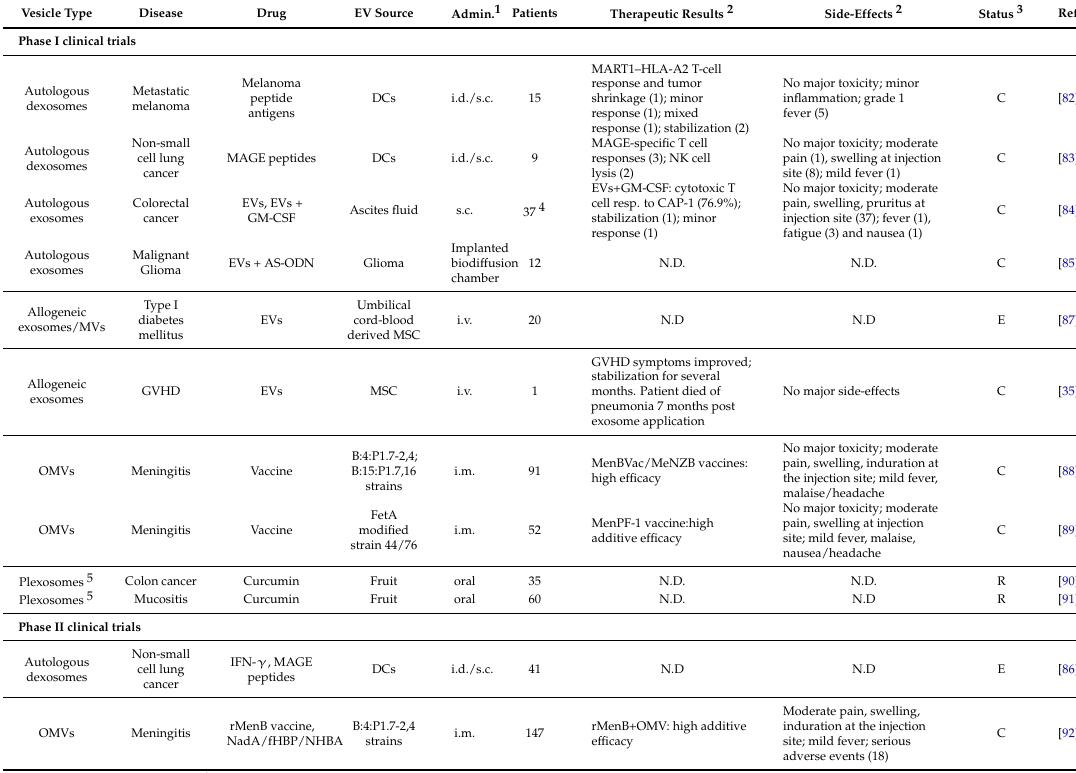
Table 1. Completed and running clinical trials of extracellular vesicle (EV)–based therapies.